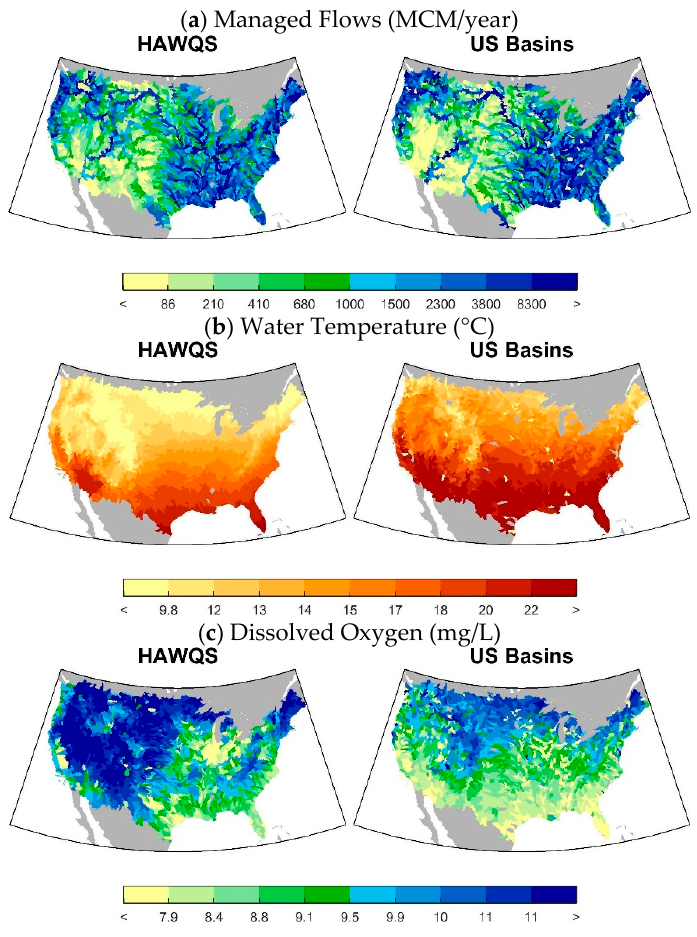
Figure 3. ( a ) Mean baseline flow (MCM/year); ( b ) water temperature and ( c ) dissolved oxygen (mg/L), 1986–2005, at the Hydrologic Unit Code (HUC) ‐ 8 watershed scale for US Basins and HAWQS.